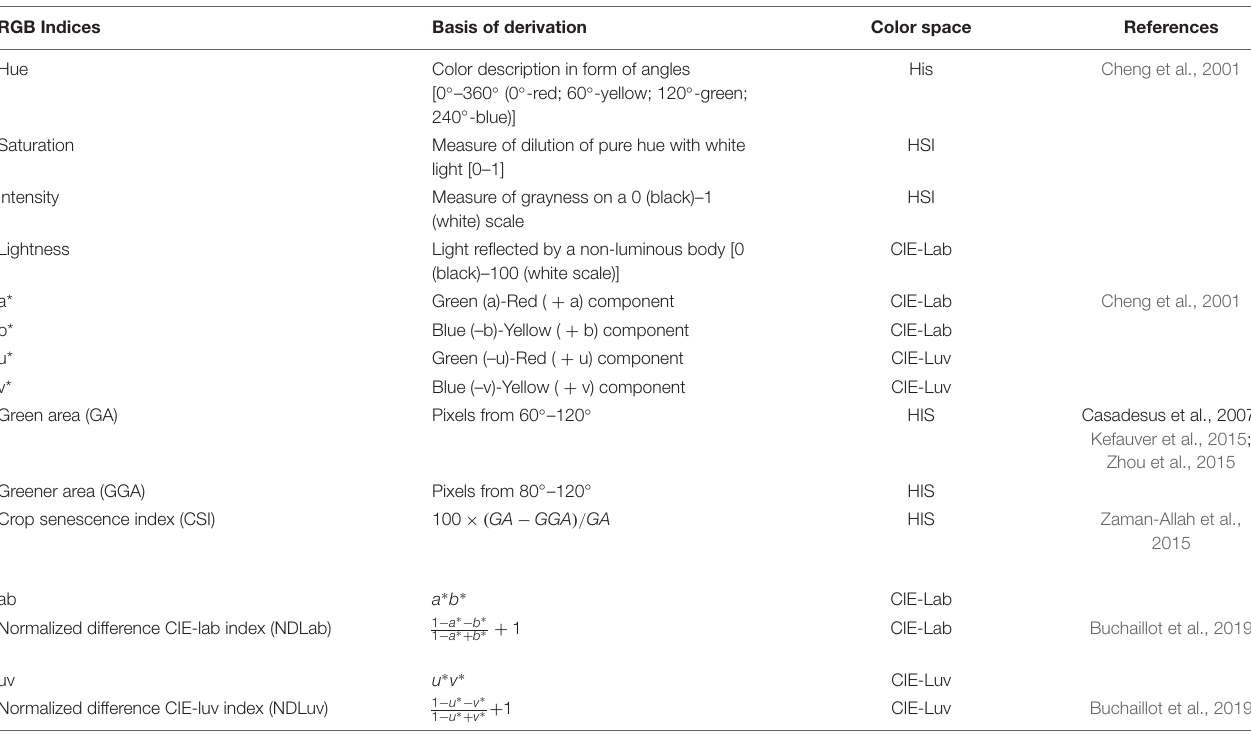
TABLE 4 | RGB indices derived from the BreedPix and their